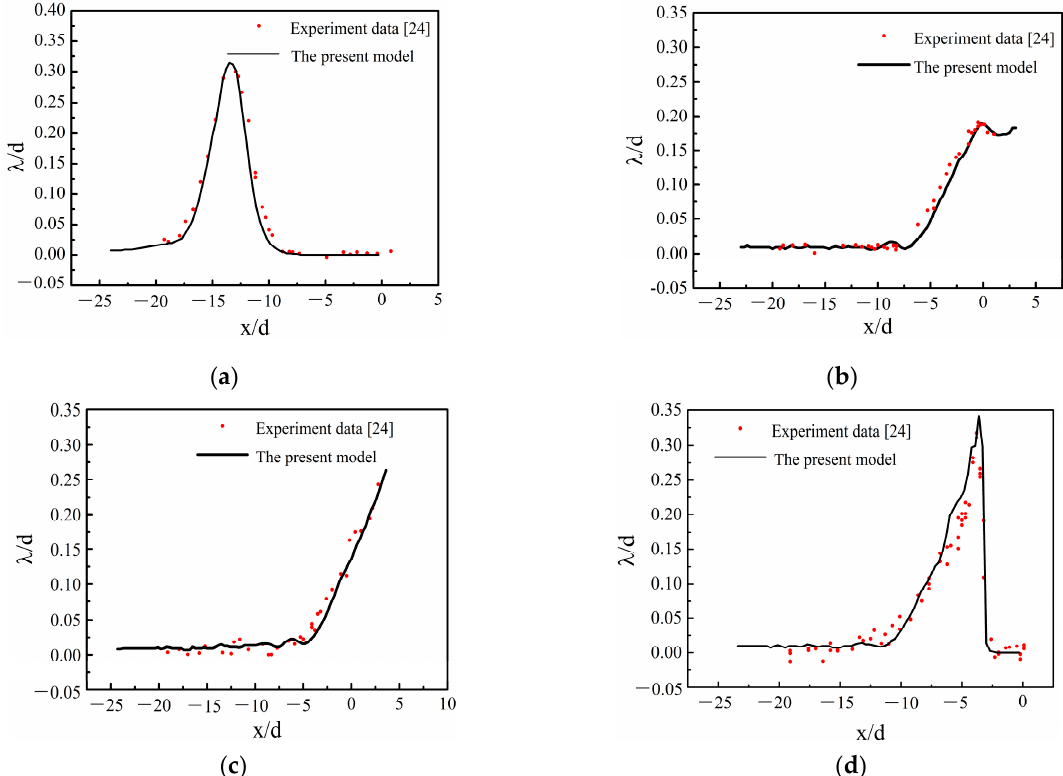
Figure 4. Comparison of wave surface profile between the proposed model and the experimental data [23]: ( a ) t = 10 s, ( b ) t = 20 s, ( c ) t = 25 s, ( d ) t = 30 s.